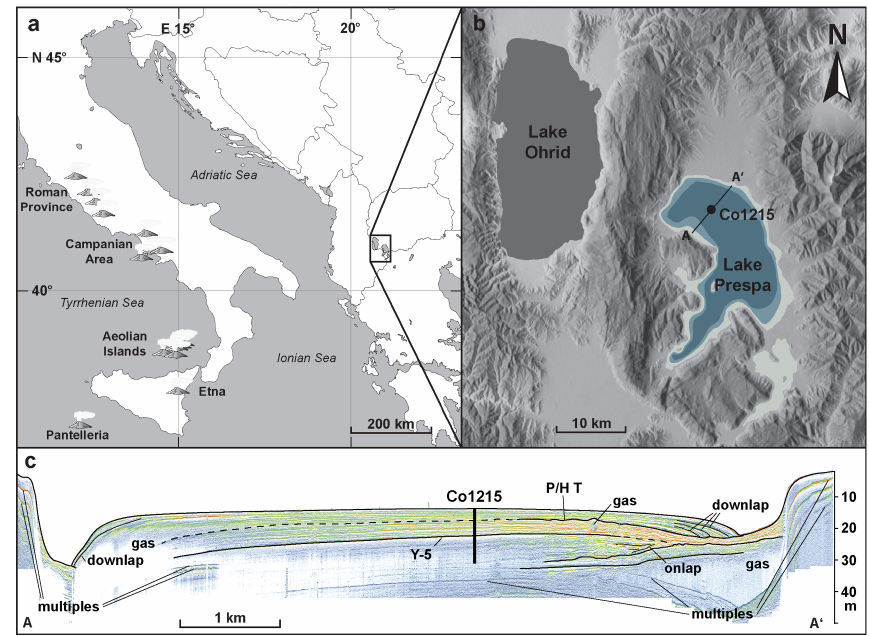
Fig. 1. (a) Map showing the location of Lake Prespa in the northeastern Mediterranean region and the distribution of Quaternary Italian volcanoes, (b) map showing the coring location of core Co1215, and (c) hydro-acoustic profile across the lake ( A − A 0 ) showing the coring location with recovery depth of Co1215, the Y-5 tephra and the Pleistocene/Holocene transition (P/HT) (modified after Wagner et al.,